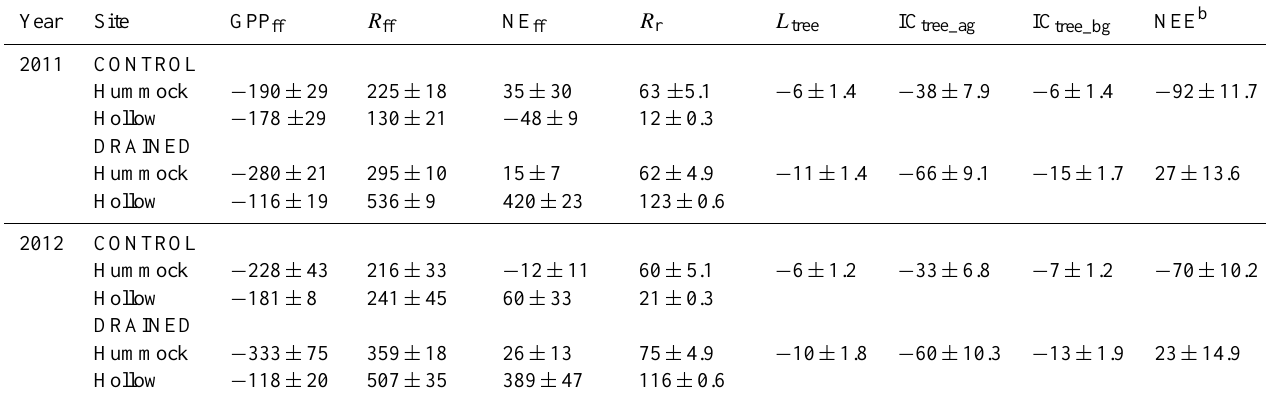
Table 4. Growing season CO 2 -C flux estimates ( ± SE,g Cm − 2 ) a . GPP ff R ff NE ff R r L tree IC tree_ag IC tree_bg NEE